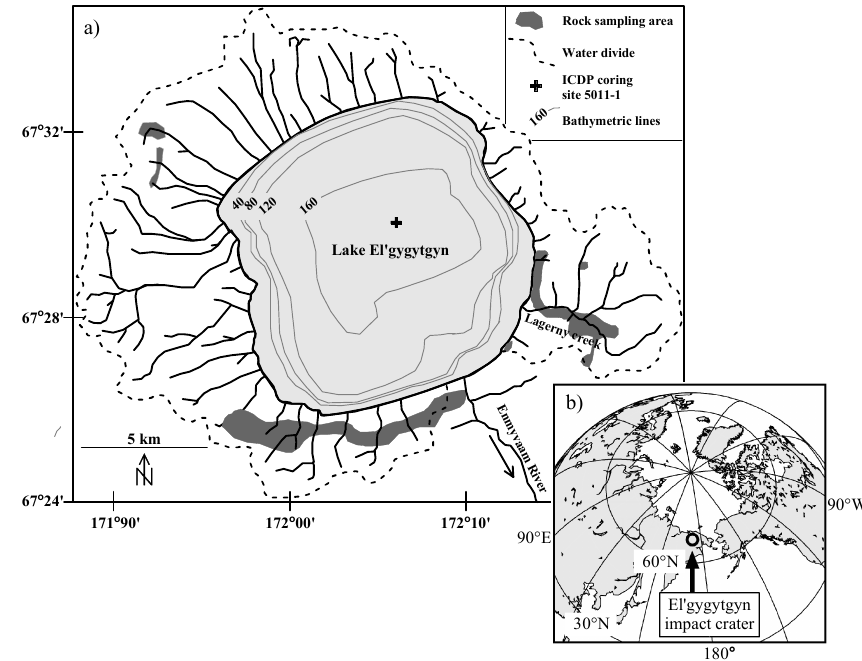
Fig. 1. Schematic map of Lake El’gygytgyn and its catchment (a) and the position of Lake El’gygytgyn in a global context (b) . Largest creeks are marked on the map by thick solid lines. The location of ICDP Site 5011-1, in the flat central part of the bowl-shaped lake floor, is marked by a cross. The rim of the impact crater mostly follows the border of the lake’s catchment (dashed line).